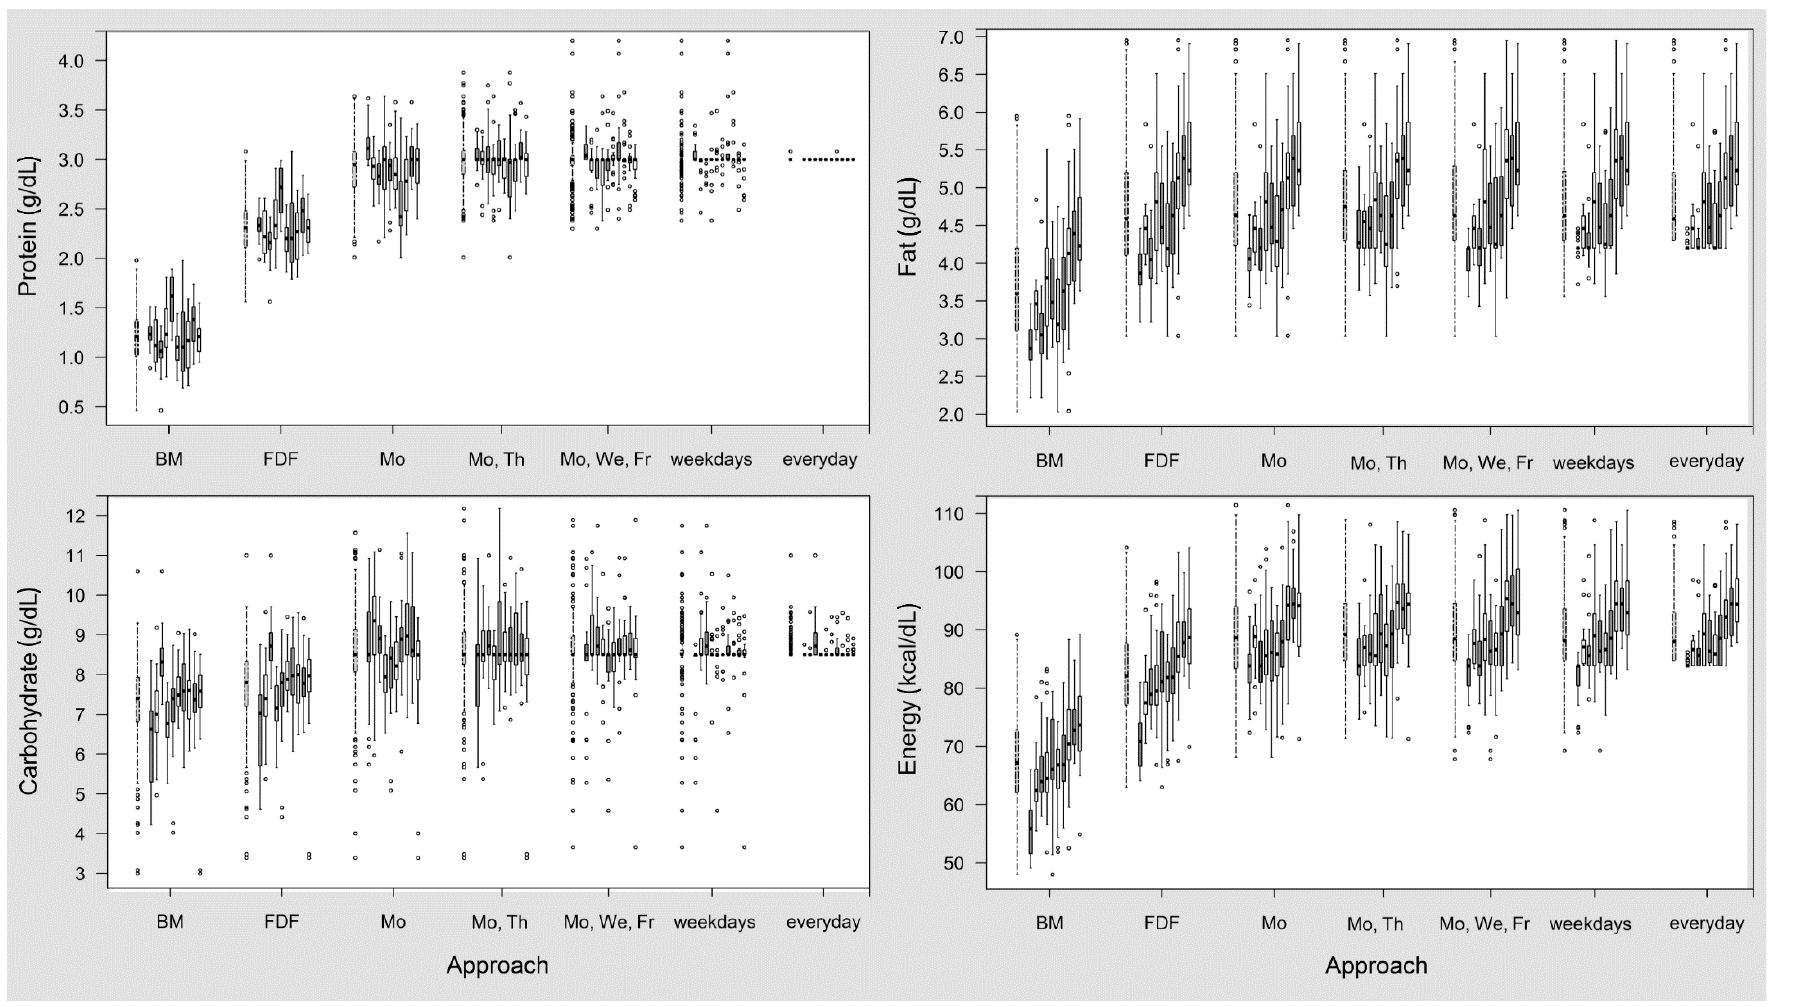
Figure 1. Variation of macronutrient and energy content in target fortified breast milk (BM) for different frequencies of measurements compared with native BM and fixed dose fortified (FDF) BM. The first boxplot of each group represents all samples ( n = 210), followed by ten boxplots with data ( n = 21) for individual